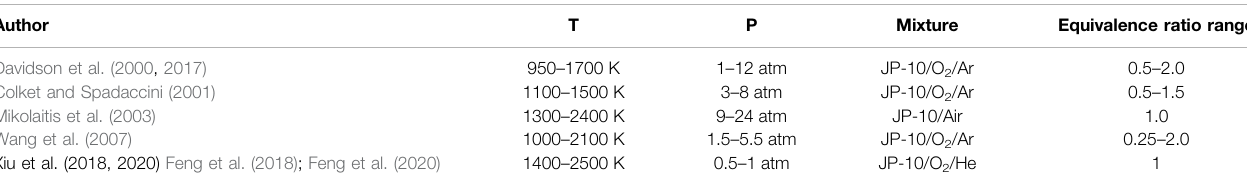
TABLE 2 | Ignition delay time studies of JP-10 in